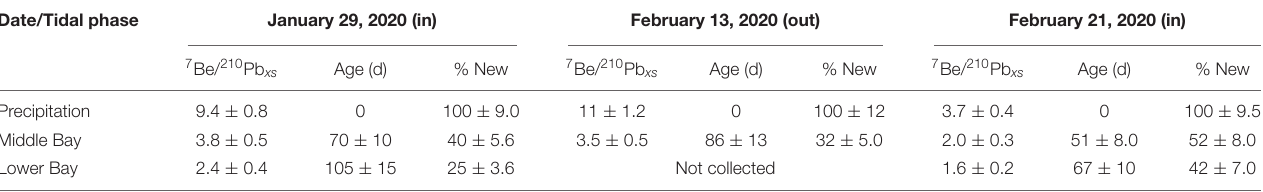
TABLE 2 | 7 Be/ 210 Pb xs ratios ± standard error calculated from activities of precipitation, suspended sediment samples with calculated suspended sediment age and percentage new